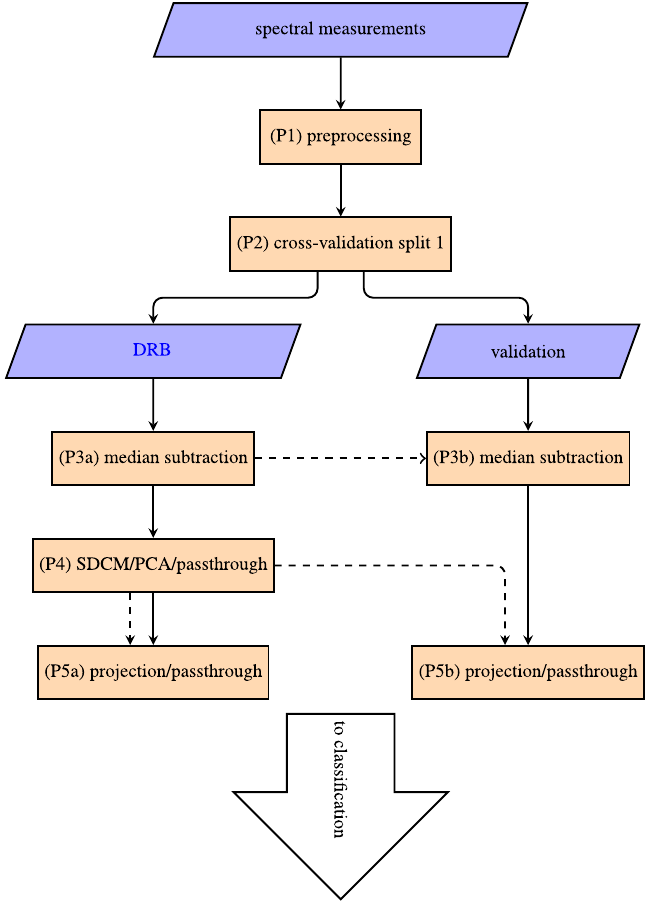
Figure 8. Flowchart of the data preparation pipeline. The solid arrows denote the data flow and the dashed arrows denote the influence by the parameters. The raw input data was preprocessed (P1) to remove background offsets and noise, to filter out overexposed measurements, to cut the data into the appropriate spectral range and to normalize it. The data was then split 25 times into 80–20% DRB and validation batches (P2). The median of each spectral bin was calculated across all DRB measurements and subtracted from both DRB and validation sets (P3a and P3b). The DR (SDCM, PCA) was applied to the DRB (P4) set. Passthrough denotes that no DR was applied for the no DR data set. The results were used to project DRB and validation into the dimensional reduced space (P5a and P5b). The final sets were used as input for the classification pipelines. Generated with pgf v3.1.9a.